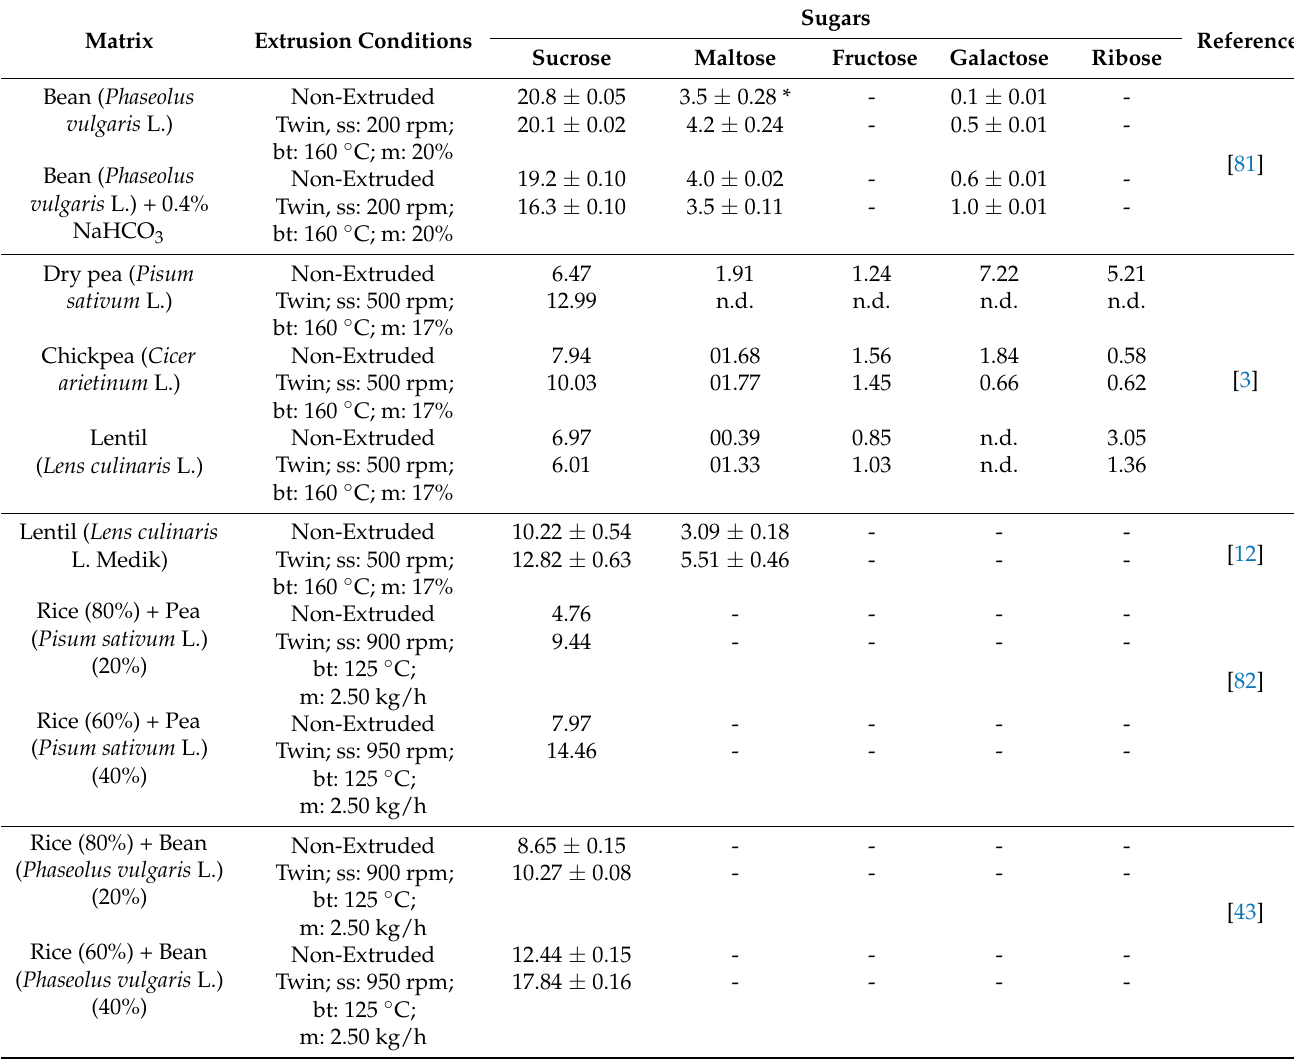
Table 2. Effect of extrusion processing conditions on sugars of different pulse